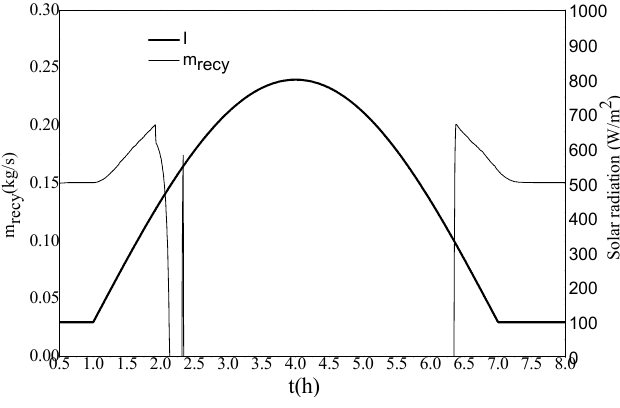
Figure 11. Variation in the amount of recycled water.